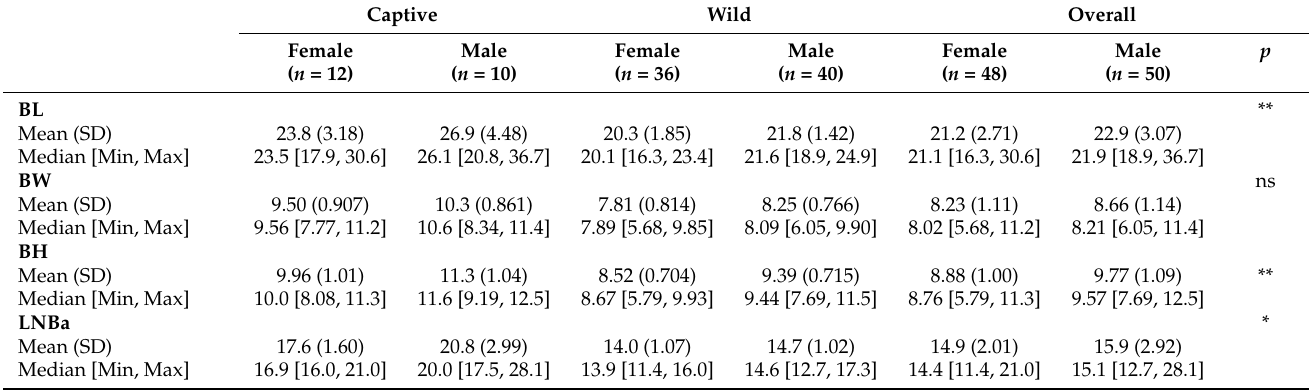
Table 1. Descriptive statistics of the morphometric data of bill characters and overall corporations of sexes using the t -test. ns: nonsignificant; *: p < 0.05; **: p < 0.01. Captive